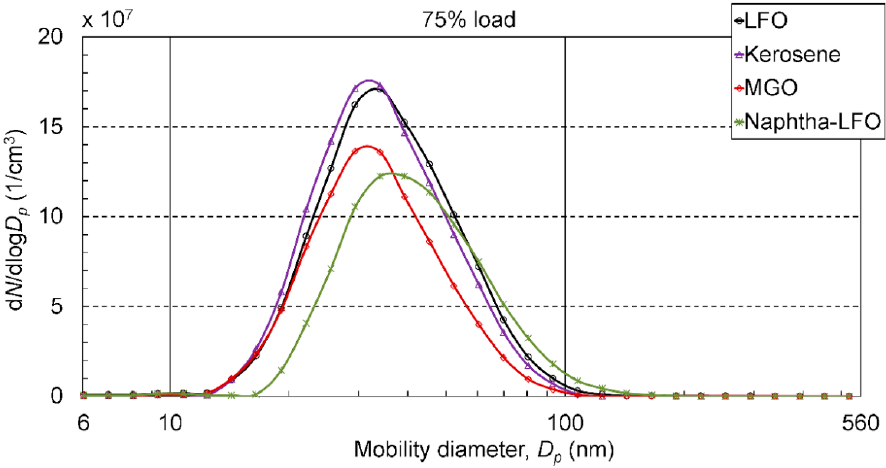
Figure 3. Exhaust PSDs at 75% load.